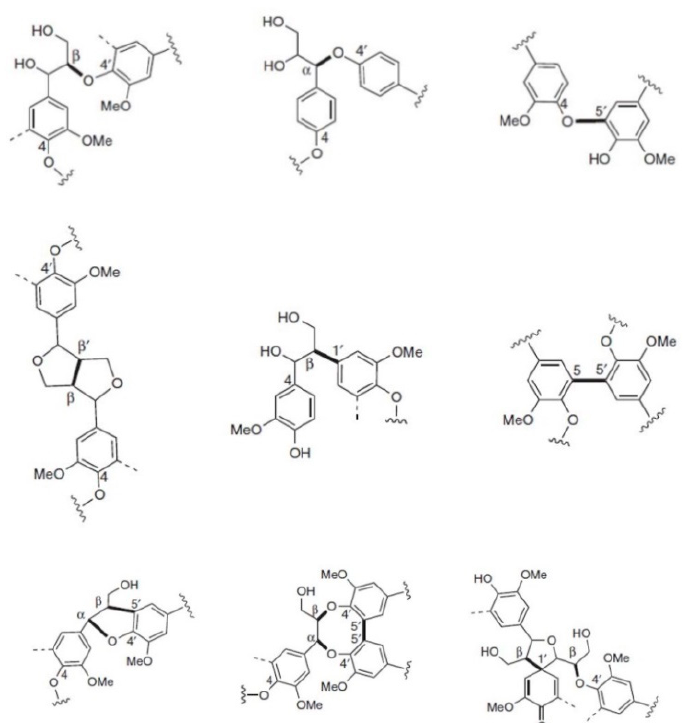
Figure 2. Most common monolignol linkages. First line: ether bonds (ß-O-4 ′ , α -O-4 ′ , 4-O-5 ′ ); second line: C–C bonds (ß-ß’, ß-1 ′ , 5-5 ′ ), and third line: more complex linkages (ß-5 ′ / α -O-4 ′ , 5-5 ′ / ß-O-4 ′ / α -O-4 ′ , ß-1 ′ / ß-O-4 ′ ). Reprinted from [15] under open access license.